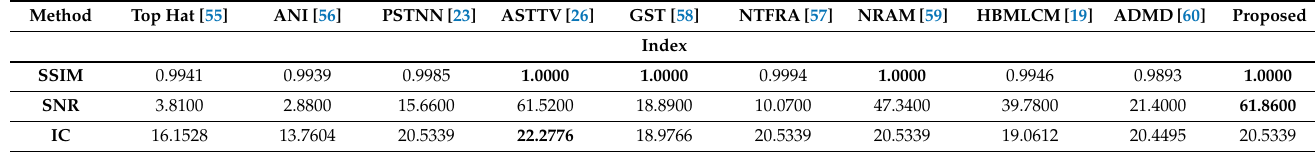
Table 5. Calculation of indicators in scenario A of each model.